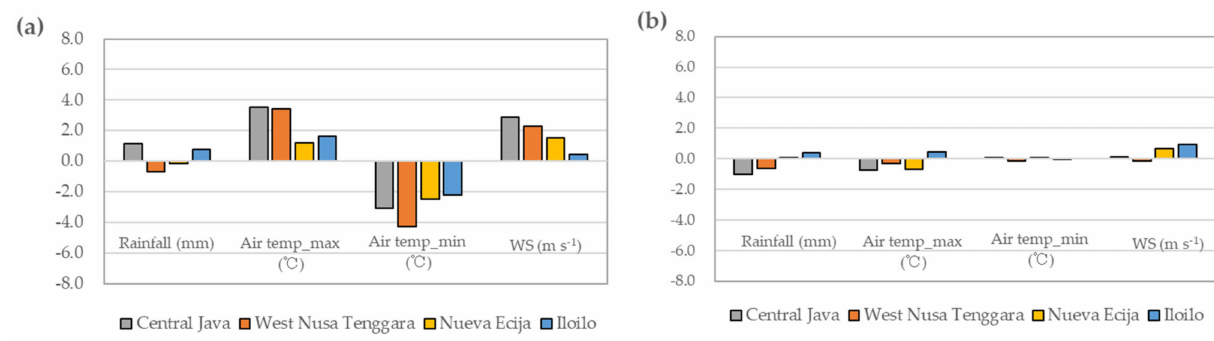
Figure 5. Mean errors between ( a ) observed weather and outputs from the SINTEX-F and ( b ) observed weather and CDFDM outputs.